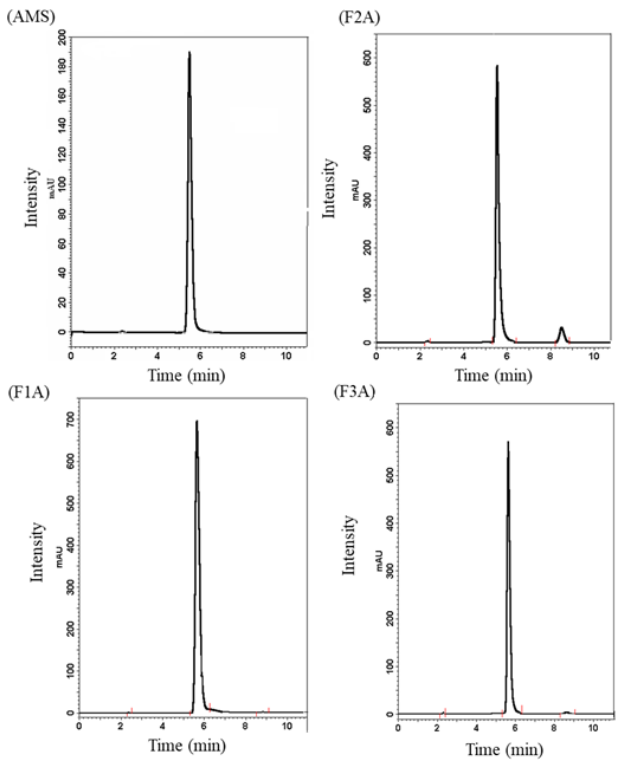
FIGURE 2 – HPLC chromatograms of AMP, F1A, F2A and F3A by UV